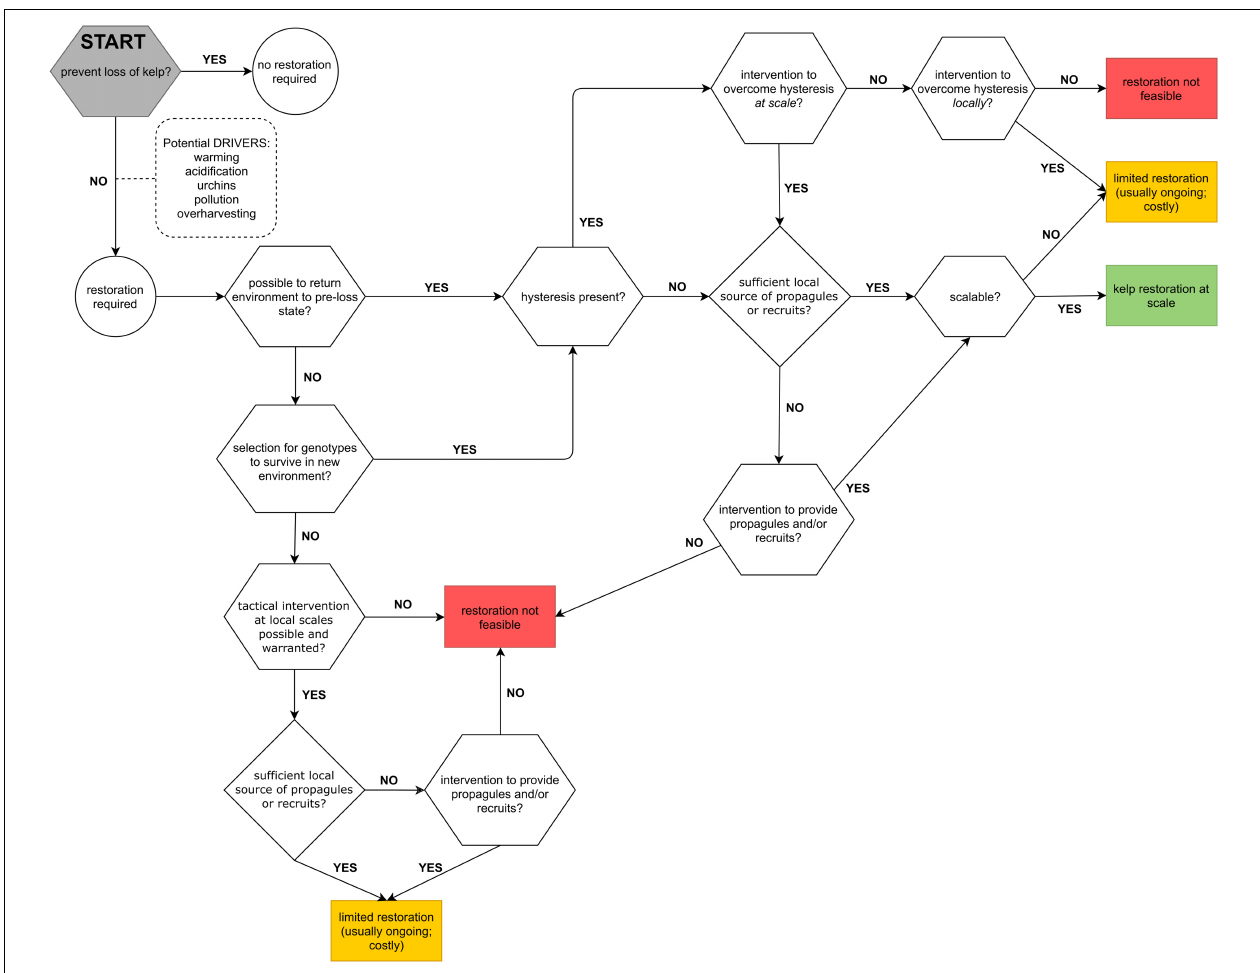
FIGURE 3 | Workflow and decision framework for kelp forest